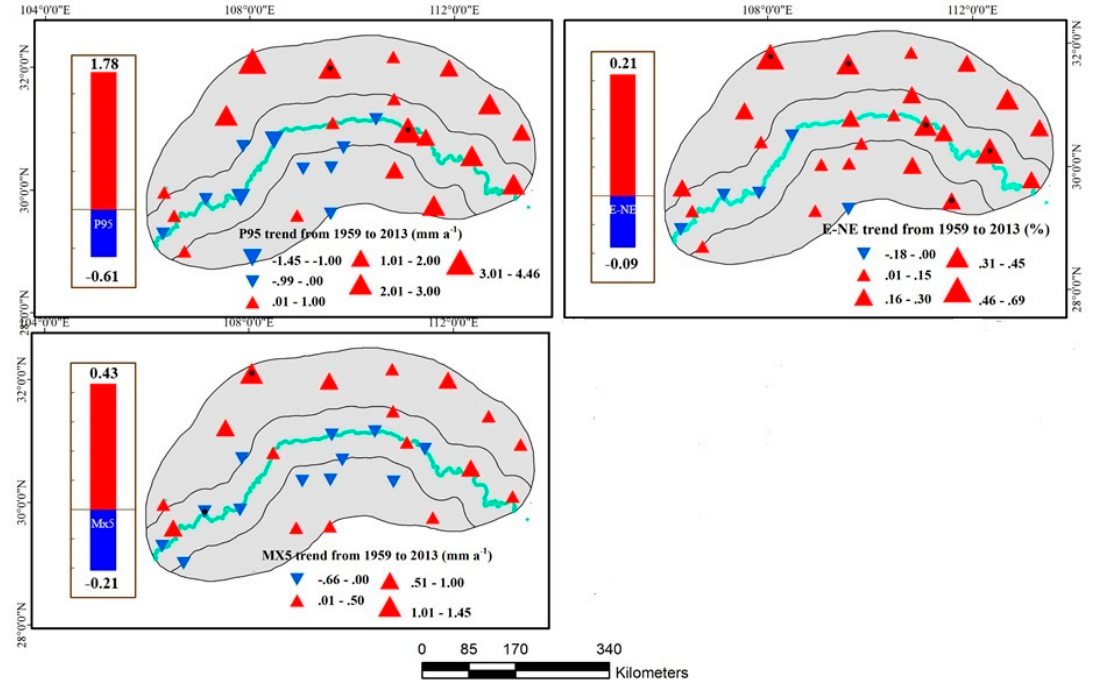
Figure 3. Changes in P95, (E–NE, Mx5 for the period of 1959–2013. Red upward and blue downward triangles indicate increasing and decreasing tendencies, respectively. The triangle size represents the magnitude of these positive and negative trends. The black spot in the triangles represents significant trends at a 5% significance level. The red bar is the median slope of upward trend stations, while the blue bar is the median slope of downward trend stations.